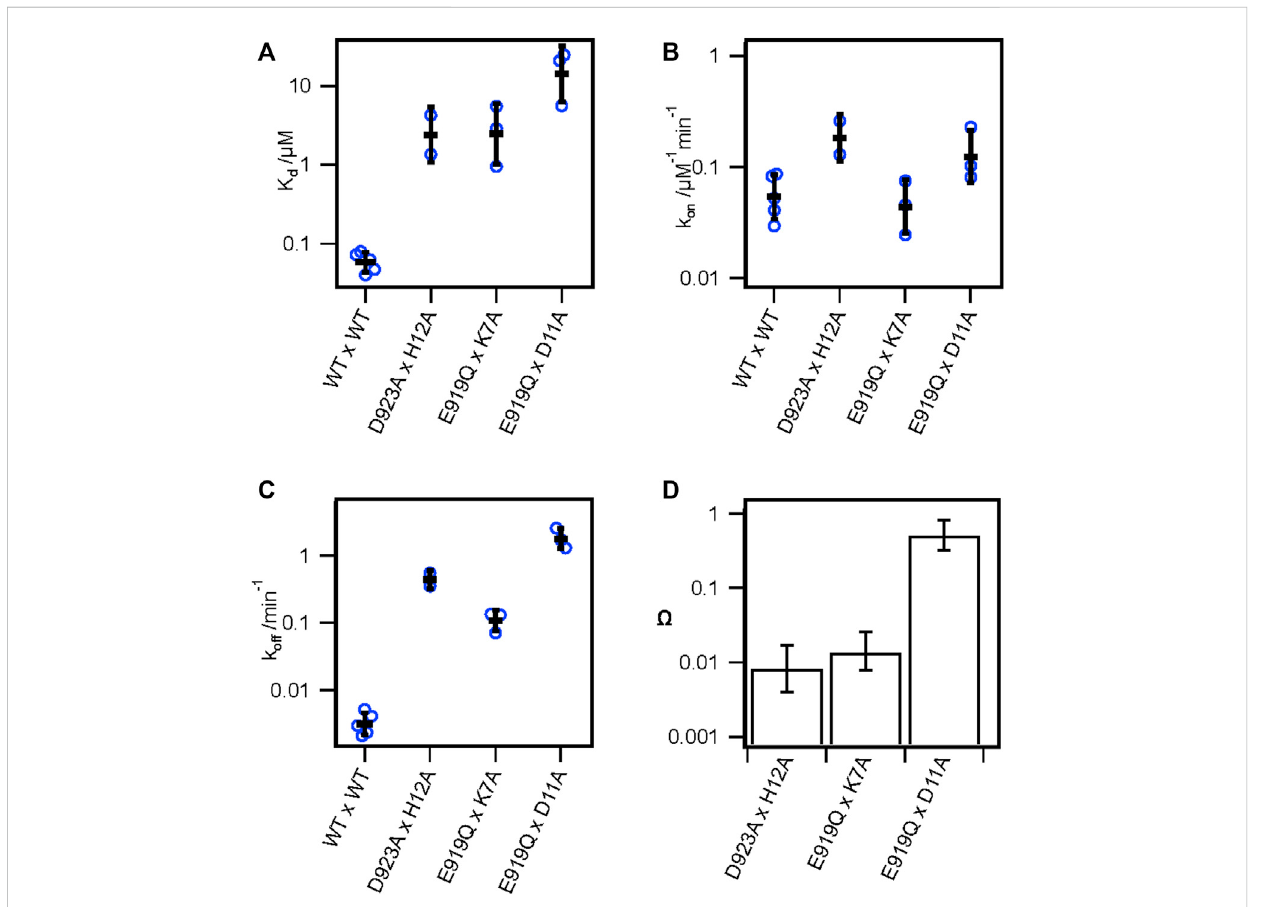
FIGURE 3 Double mutant cycle analysis supports key pairwise interactions between KIIIA and hNa V 1.7. (A) K d , (B) k on , and (C) k off from double-mutant experiments of thermodynamic double-mutant cycles between H12A x D923A, K7A x E919Q, and D11A x E919Q. Bars are geometric mean ± SD, n = 2 – 5 cells per condition (reported in Table 3), and empty circles are individual cells. (D) Coupling coef fi cients Ω ±error calculated from linear propagation of SEM of K d values from single and double-mutation experiments reported in Table